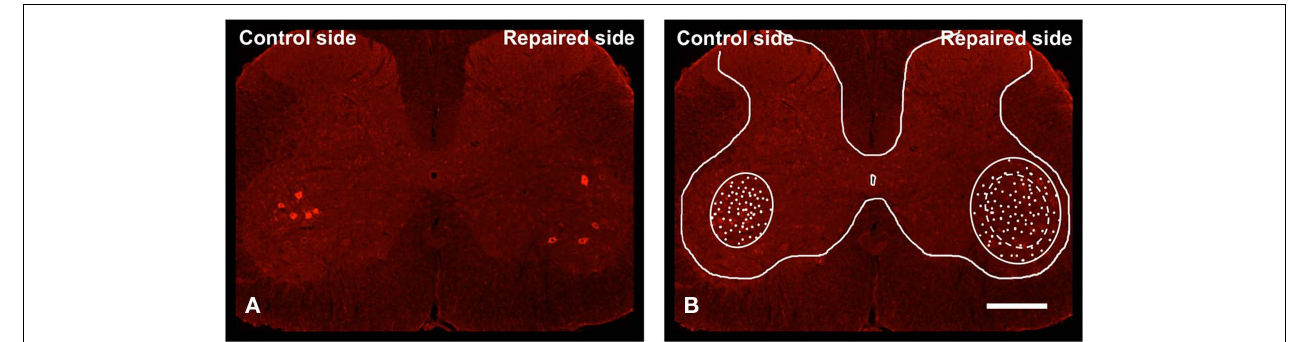
FIGURE 1 | Micrograph from a single separate transverse L5 spinal cord section showing RLMs bilaterally to the lateral gastrocnemius muscle (LGC) in the lateral ventral horn 6months after transection and repair of